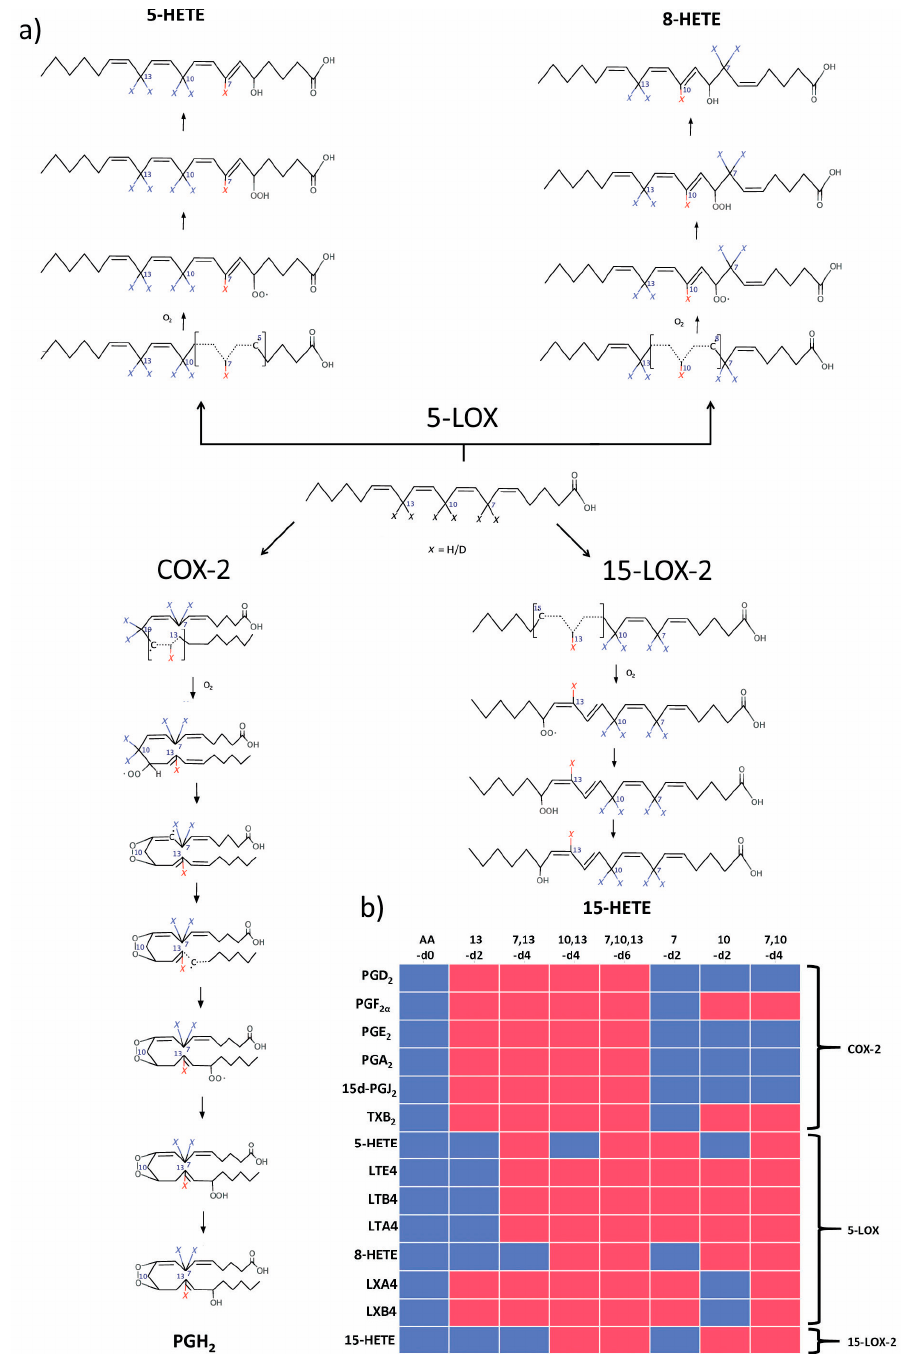
Figure 4. (Bis-allyl)-deuterated AA library for a controlled synthesis of eicosanoids. ( a ) Reaction mechanism scheme. ( b ) Intended effects of treatment with different deuterated AA on pro- and anti-inflammatory eicosanoids synthesis in vivo (red—reduced reaction rate, blue—no effects).